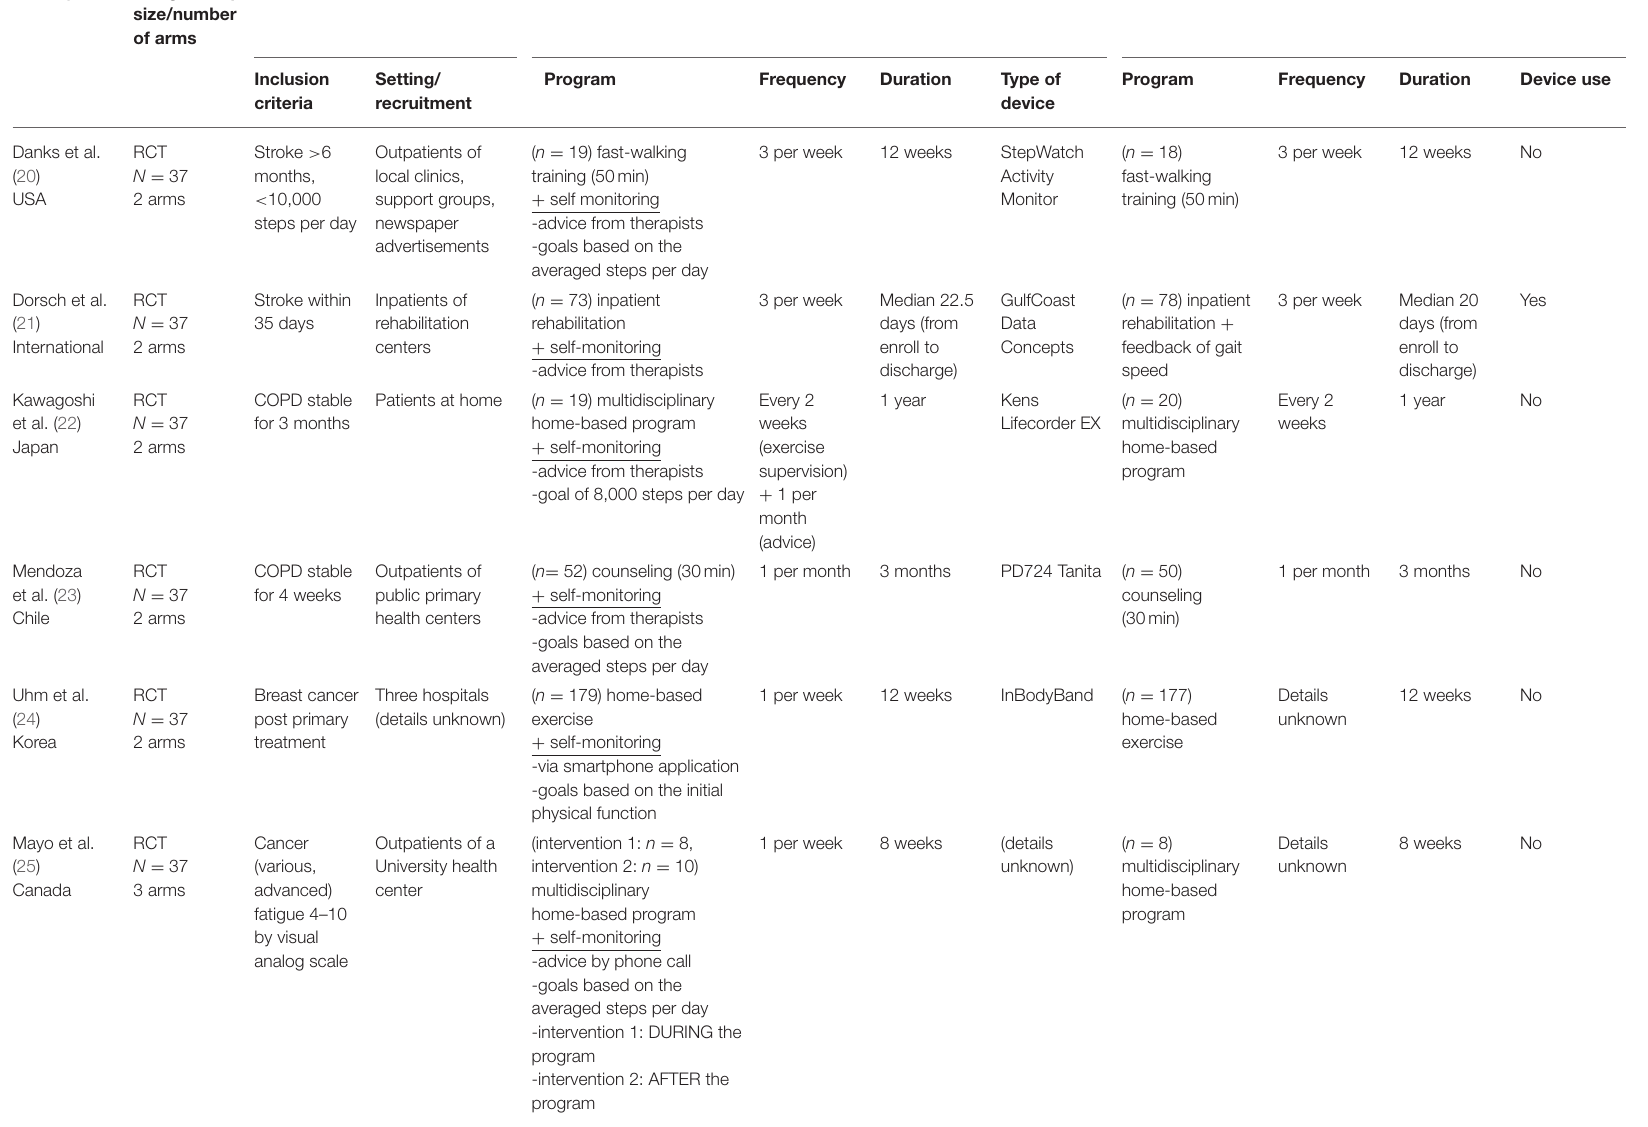
TABLE 1 | Characteristics of the included studies 1: Study design and methods. References/